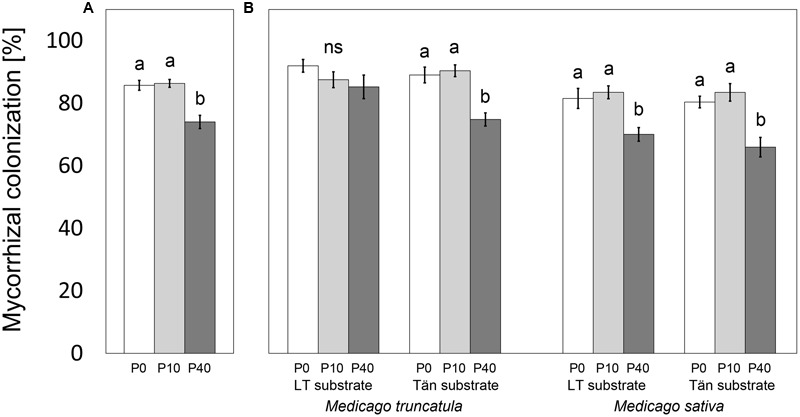
Mycorrhizal colonization of plants inoculated with Rhizophagus irregularis ‘PH5’ affected by the addition of 0, 10, or 40 mg pot-1 of phosphorus (P0, P10, and P40, respectively). The results are shown either for the whole data set (A), or separately for Medicago truncatula or M. sativa plants grown in sand–zeolite substrate with 10% of either Litoměřice or Tänikon soil (LT or Tän substrate, respectively) (B). Colonization is expressed as percentage of root length occupied by mycorrhizal fungal structures such as hyphae, arbuscules, and/or vesicles. Means ± standard errors are shown (n = 19 or 20 for A, n = 4 or 5 for B). Different letters indicate significant differences between different P levels within each plant–substrate combination according to Tukey’s HSD test (p < 0.05); ns, p ≥ 0.05. The roots of control non-mycorrhizal plants remained free of mycorrhizal fungal structures (data not shown).